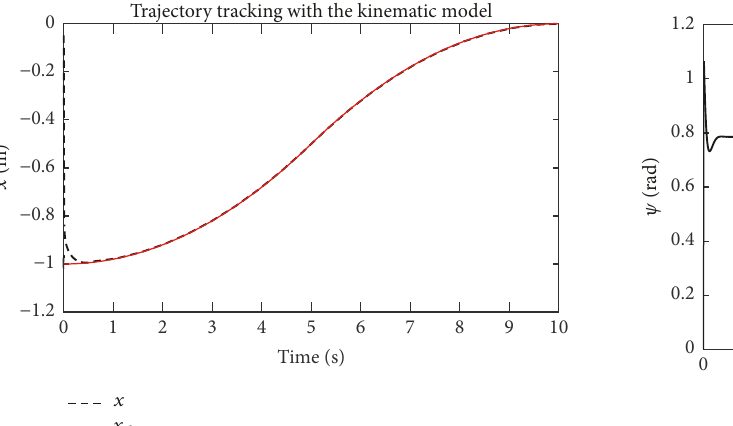
Figure 11: Rotation angle in the case of kinematic predictive control.